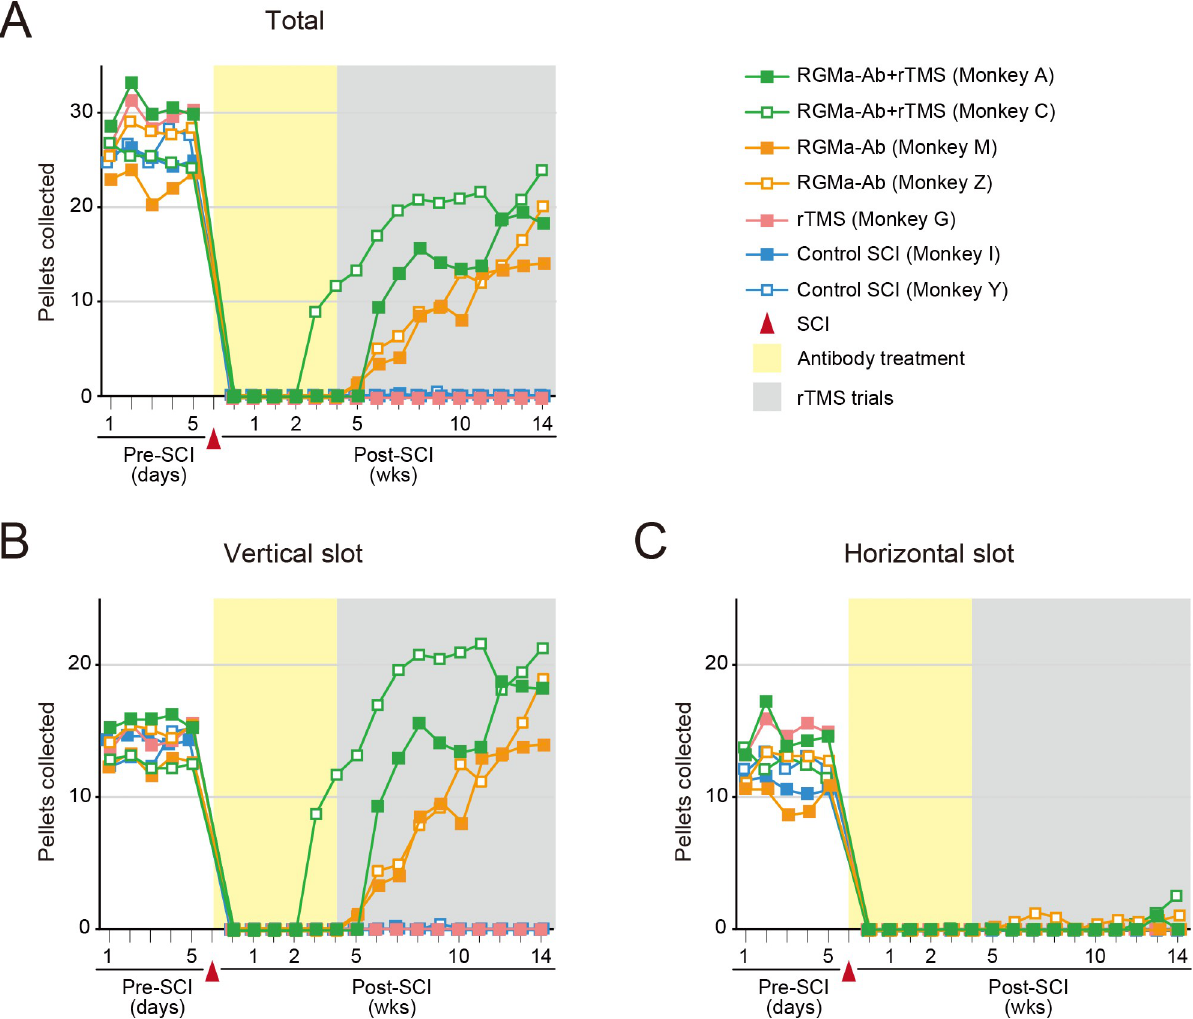
Fig 3. Results of behavioral assessment based on the modified Brinkman board test in the seven monkeys tested. (A) Total number of pellets collected through both the vertical and the horizontal slots. (B) Number of pellets collected through the vertical slots. (C) Number of pellets collected through the horizontal slots. Note that rTMS combined with the antibody treatment appears to yield a more rapid improvement in the motor performance requiring manual dexterity, compared with the antibody treatment alone.